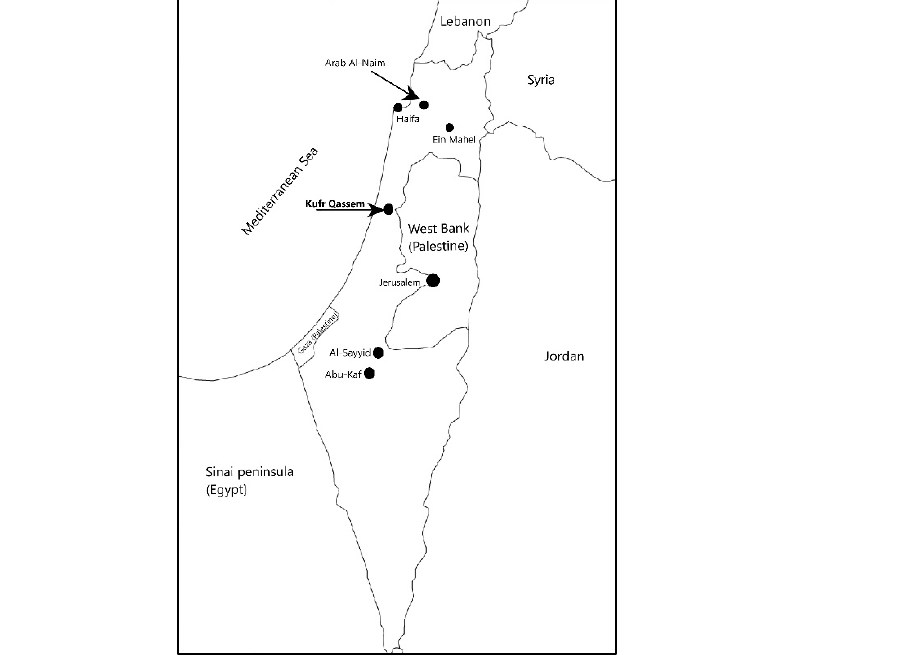
Figure 1. Map of Israel with the locations of several sign language communities.